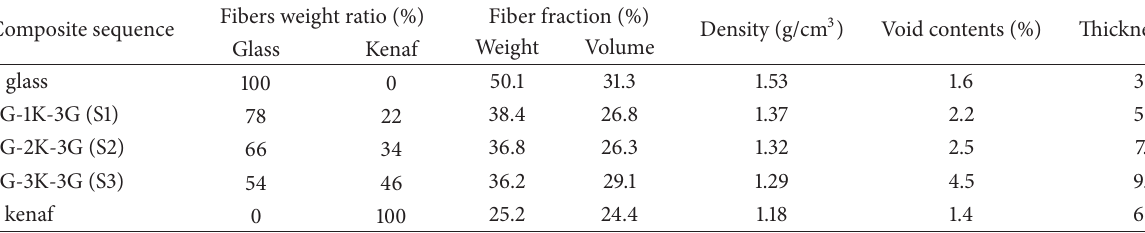
Table 1: Designation and physical properties of hybrid composites.